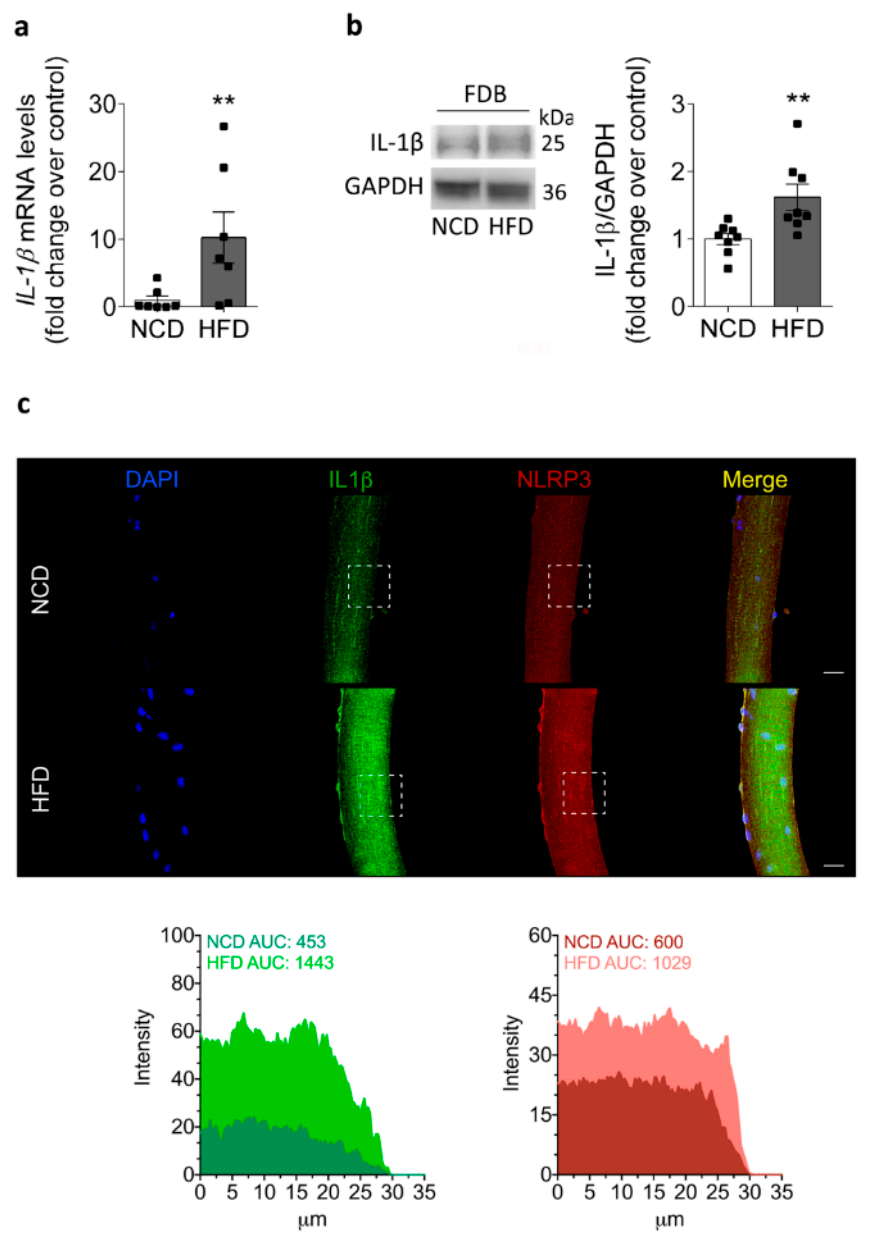
Figure 4. Increased IL-1 β mRNA, protein levels, and distribution in the skeletal muscle of HFD-fed mice. ( a ) Relative IL-1 β mRNA levels in isolated adult FDB fibers from NCD- and HFD-fed mice measured by RT-qPCR and normalized to GAPDH. Values represent the mean ± SEM from six in- dependent determinations. ** p < 0.01, determined by Student’s t -test statistical analysis. ( b ) Repre- sentative Western blot showing IL-1 β protein content in homogenates prepared from the FDB mus- cle isolated from NCD- or HFD-fed mice at 8 weeks. Each lane was loaded with 60 μ g of total pro- tein. Values represent the mean ± SEM ( n = 7). ** p < 0.01, determined by Student’s t -test. ( c ) Repre- sentative confocal images of isolated adult FDB fibers from NCD- and HFD-fed mice, illustrating the localization of IL-1 β (green) and NLRP3 (red). DAPI staining of the nuclei is shown in blue. The area under the curve (AUC) was measured on white squares, and represented as fluorescence in- tensity. Scale bar: 20 μ m.